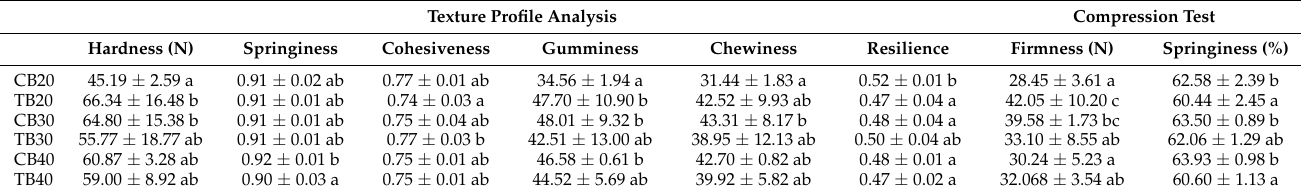
Table 2. Instrumental texture analysis of polenta samples prepared from corn meal enriched in common (CB) and Tartary (TB) buckwheat flour at various